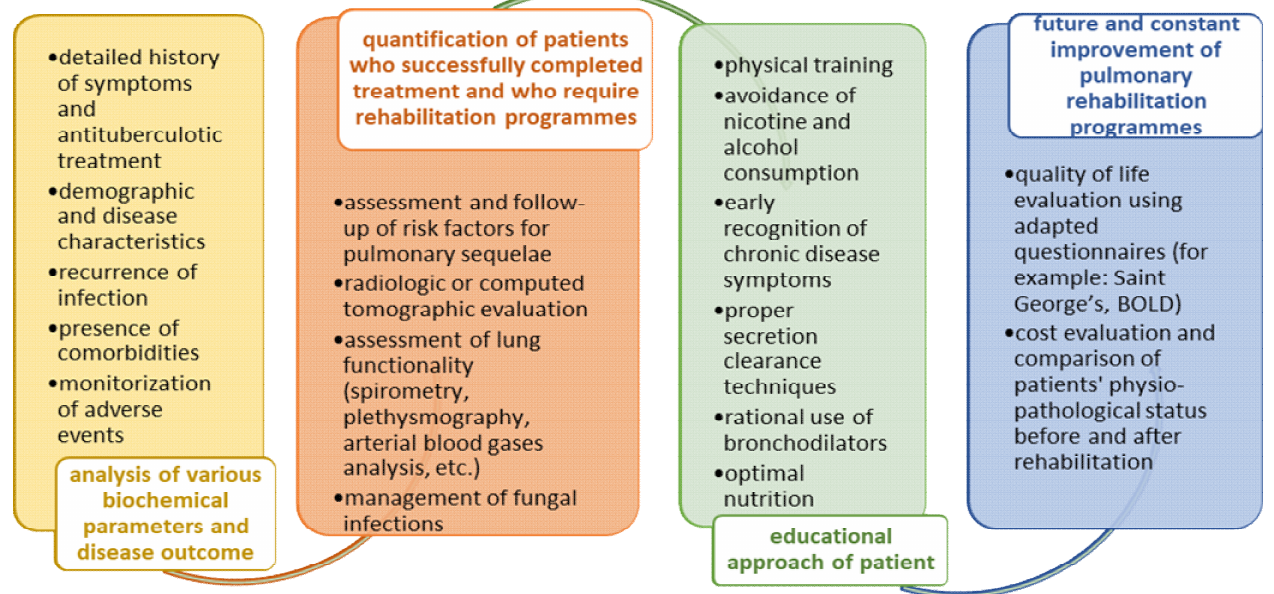
Figure 3. Recommendations for post-TB disease management.